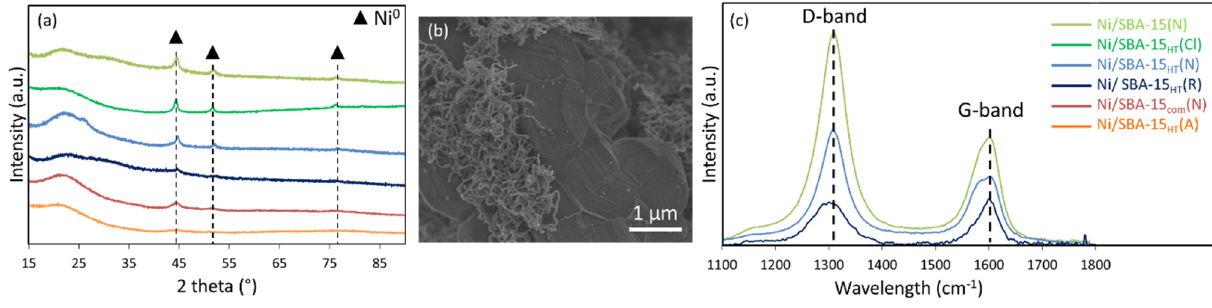
Figure 7. ( a ) X-ray diffractograms of the spent catalysts, ( b ) SEM image of the spent Ni/SBA-15(N), and ( c ) Raman spectra of some spent catalysts.